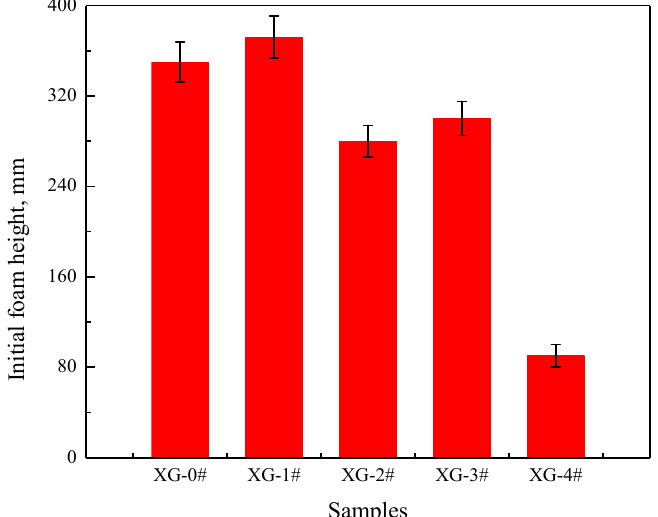
Figure 3. Foaming ability of the foam dispersions.